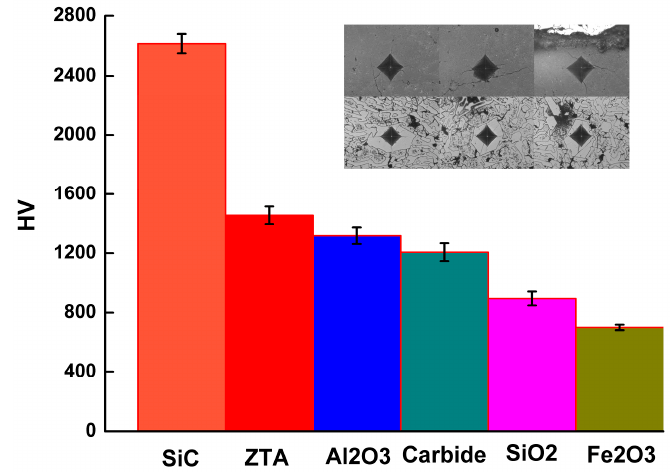
Figure 5. Micro-hardness of the abrasives and the composite area.